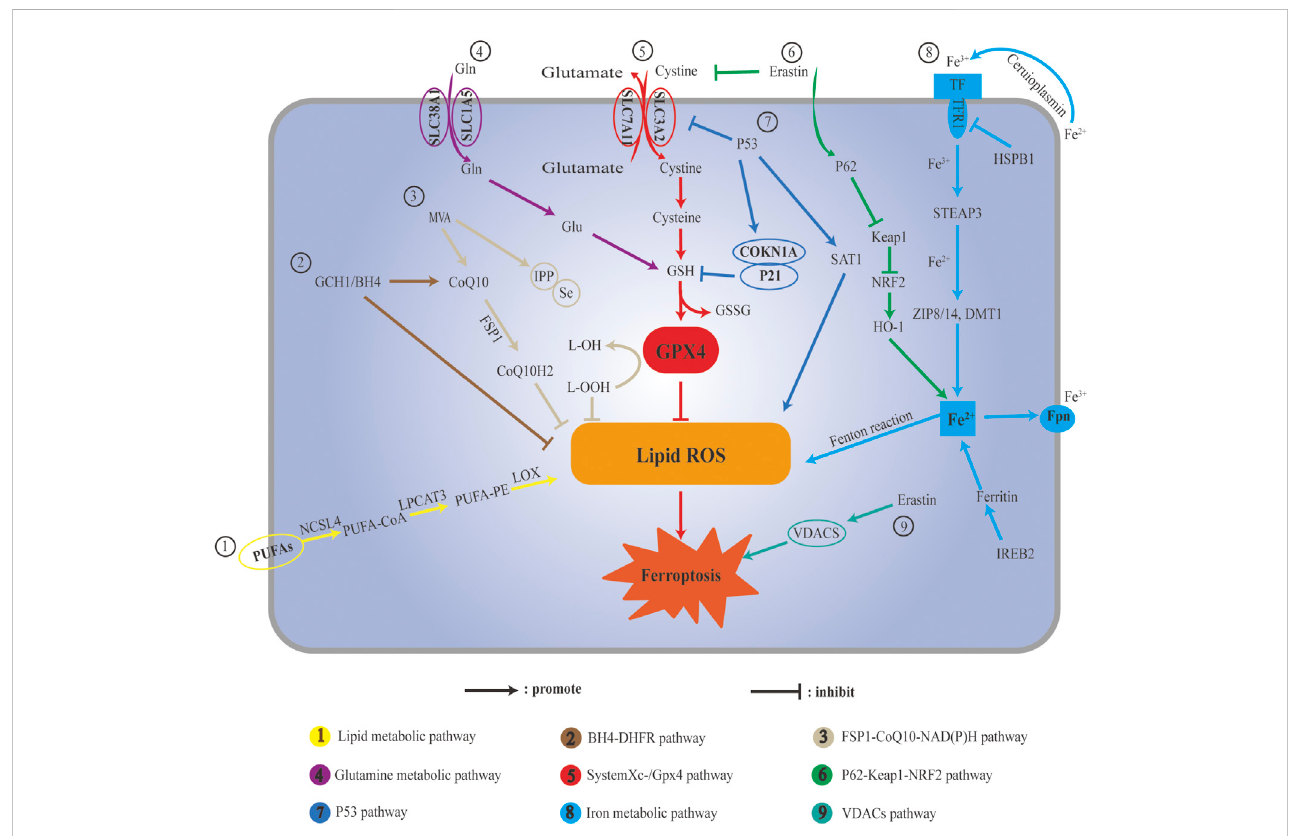
Schematic illustration ferroptosis pathways. (A) Lipid metabolic pathway; (B) BH4-DHFR pathway; (C) FSP1-CoQ10-NAD(P)H pathway; (D) Glutamine metabolic: (E) c; (F) P62-Keap1-Nrf2 pathway; (G) P53 pathway; (H) Iron metabolic pathway; (I) VDACs